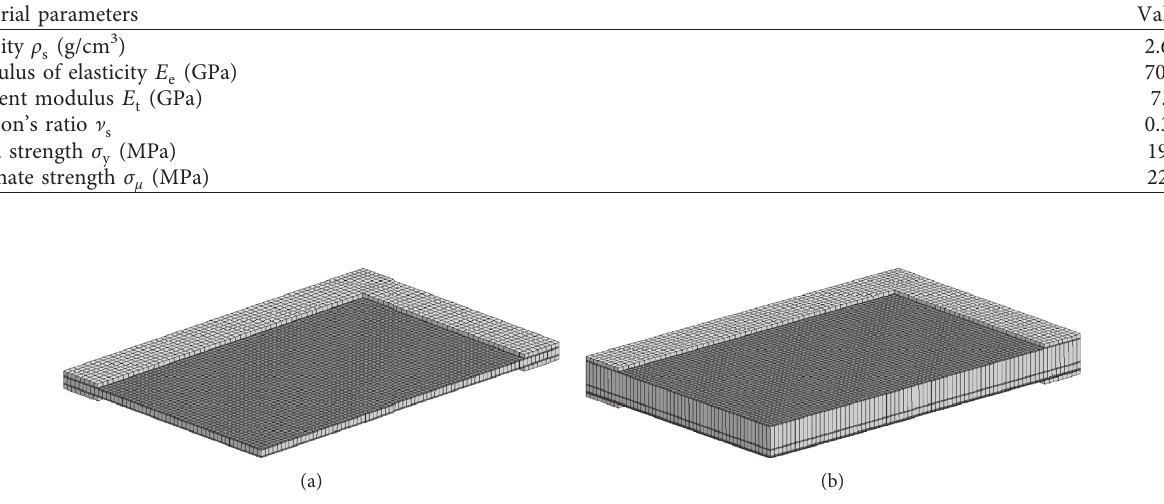
Figure 25: 1/4 finite element model. (a) ST1 and ST2. (b) ST4 (including